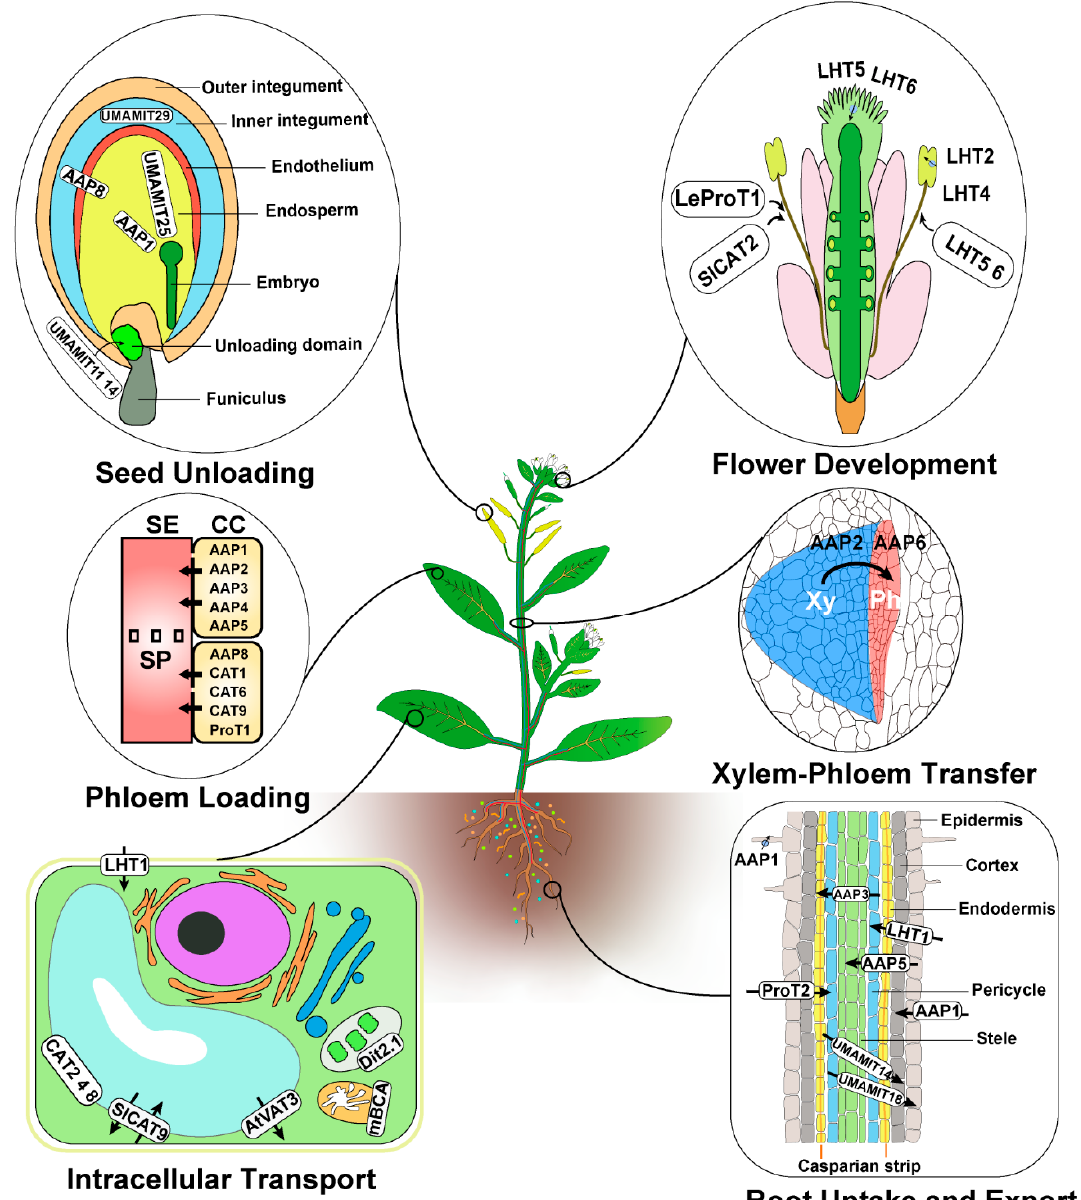
Figure 1. Summary of the role and site of action of characterized amino acid transporters in plants. The amino acid transporters mentioned in the main text play roles in root uptake and export, xylem–phloem transfer, intracellular transport, phloem loading, flower development, and seed unloading. Seed cross-section drawing is based on published micrographs [99,100]. Root section drawing is based on several reviews and research articles [1,12,48,104]. Black arrows cross rounded white boxes refer to the direction of transport when known. Information about the roles of each transporter highlighted here is provided in the reference list (Supplemental Table S1). Xy, xylem; Ph, phloem; SE, sieve tube; SP, sieve plate; CC, companion cell.